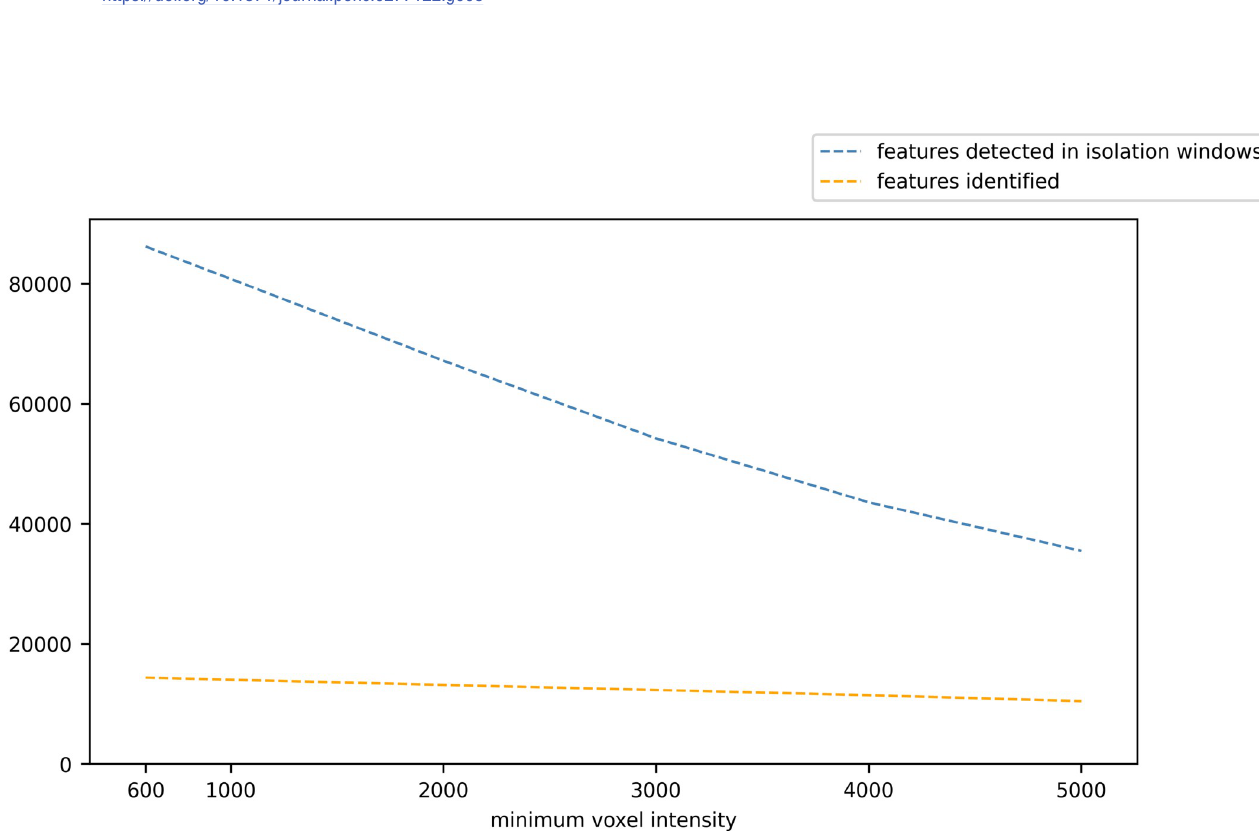
PLOS ONE | https://doi.org/10.1371/journal.pone.0277122 November30,